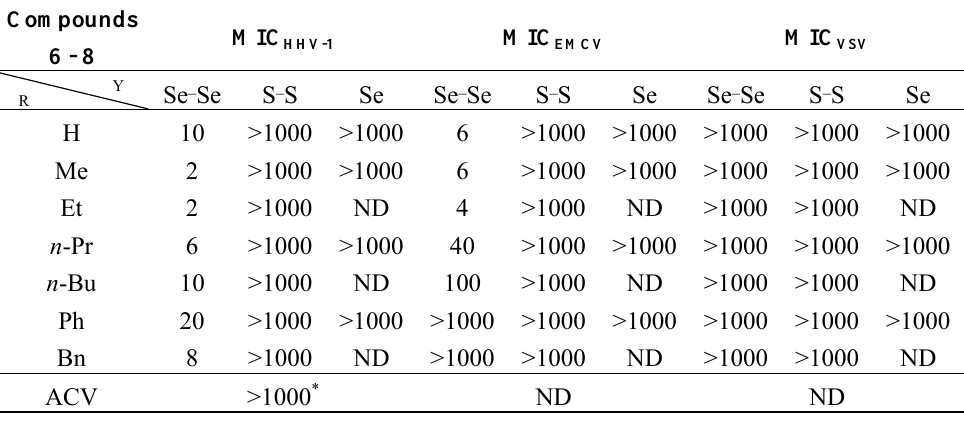
Table 3. Comparison of the virucidal activity of diselenides 6 , disulfides 7 and selenides 8